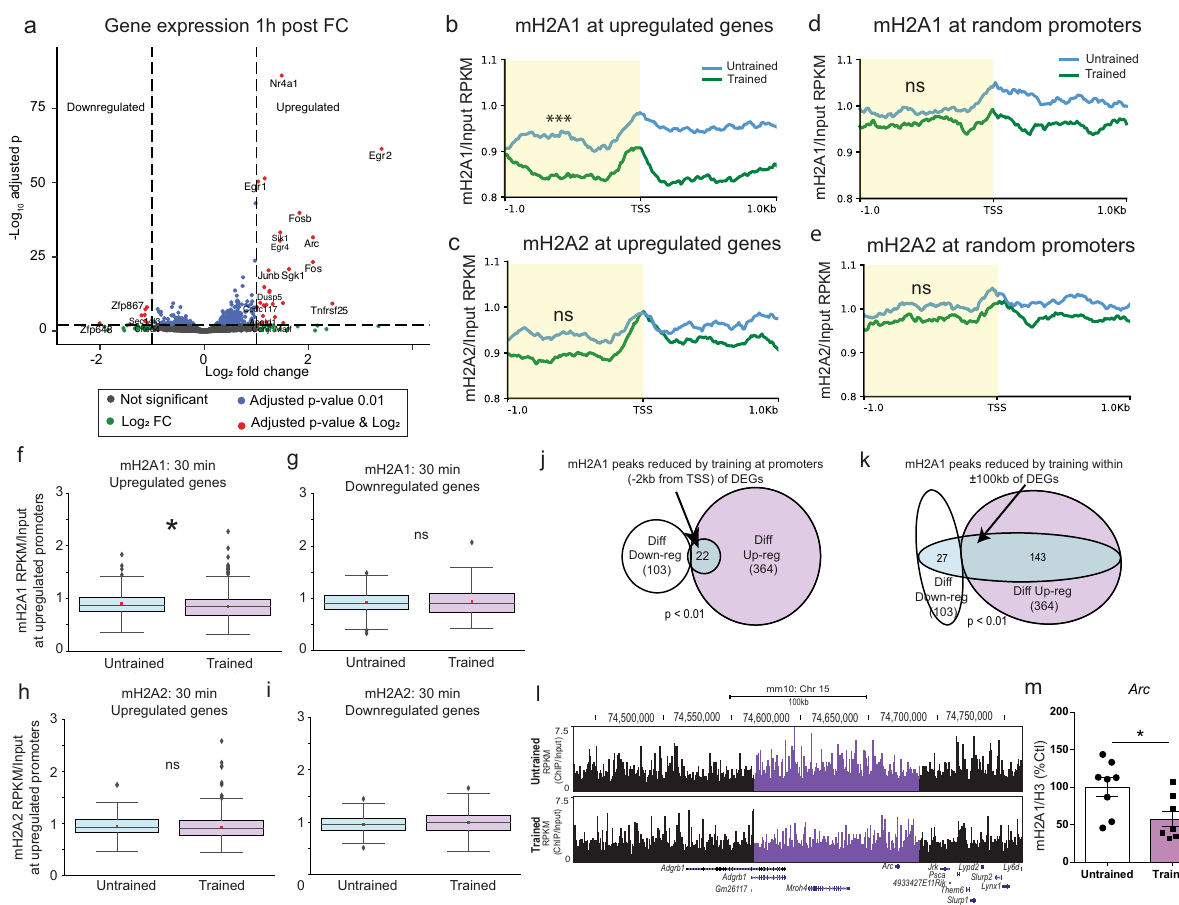
Fig. 6 Learning-induced mH2A1 removal after 30 min occurs on upregulated genes. a Analysis of gene expression 1 h after contextual fear conditioning ( n = 3 untrained, 2 trained). Blue and red circles indicate signi fi cantly altered genes. 364 of 467 differentially expressed genes (DEGs) were upregulated with fear conditioning. Average pro fi le plot of b mH2A1 and c mH2A2 binding at TSS- fl aking regions of upregulated genes. Upon training, mH2A1 signal is signi fi cantly reduced on promoters compared to untrained controls. There is no difference in mH2A2 binding on promoters of upregulated genes between trained and untrained mice. Average pro fi le of d mH2A1 and e mH2A2 binding at promoters of randomly selected genes. There is no statistical difference in mH2A1 or mH2A2 binding on randomly selected promoters between trained and untrained mice. f , g Box plots comparing mH2A1 binding RPKM (mean across replicates) normalised to mean input RPKM values at promoters ( − 2 kb) in trained vs untrained mice on up- and down-regulated genes. Similarly, box plots were generated at h Upregulated DEGs and i Downregulated DEGs for comparison of mH2A2 binding between untrained and trained mice. Only mH2A1 shows a signi fi cant decrease in binding in trained compared to untrained samples for upregulated DEGs promoters, while mH2A2 show no signi fi cant changes in its binding in trained compared to untrained samples for either up or down regulated DEGs. j Venn diagrams demonstrating signi fi cant over-representation ( p < 0.01, hyper-geometric test) of reduced mH2A1 signal on promoters (proximal regions) of differentially upregulated compared to promoters of upregulated DEGs. k Venn diagrams demonstrating signi fi cant over-representation ( p < 0.01, hyper-geometric test) of reduced mH2A1 signal on extended regions ( fl anking ±100 kb from the centre of the peak) of upregulated compared to downregulated DEGs, implicating distal regulatory elements (e.g., enhancers/silencers). l University of California at Santa Cruz (UCSC) Genome Browser track (mm10 assembly) demonstrating signi fi cant decrease in mH2A1 binding 30 min after fear conditioning. Reads are normalised by dividing ChIP by Input. m To validate the learning-induced mH2A1 reduction observed with ChIP-seq, we fear conditioned a separate set of mice ( n = 8/group) and measured mH2A1 binding (normalised to H3) 30 min later. As with ChIP-seq, there was a signi fi cant reduction in mH2A1 binding at the Arc promoter upon learning. Data are shown as mean ± SEM. (ns p > 0.05, * p <